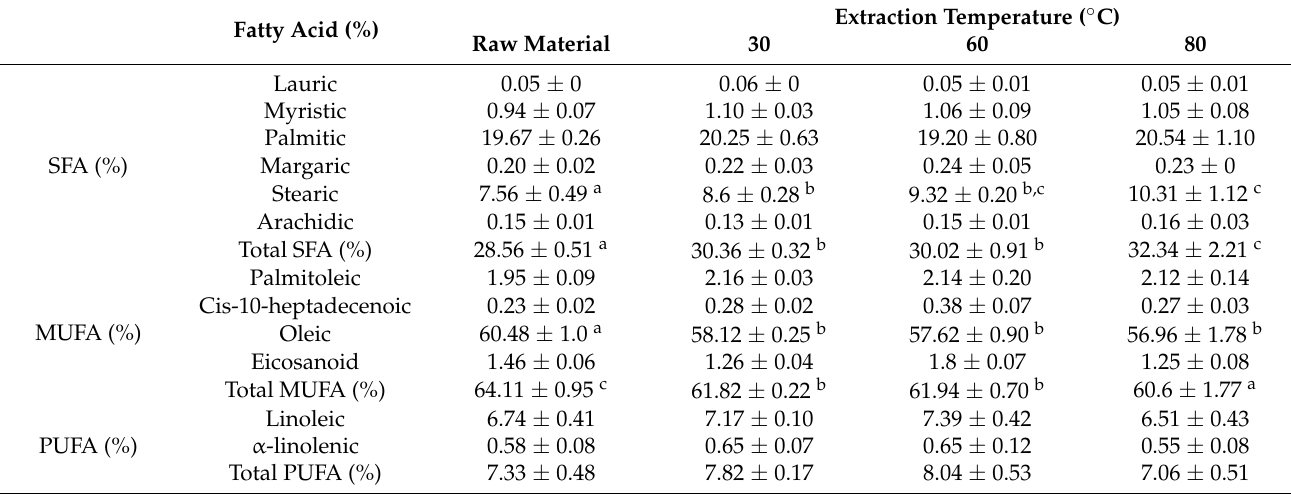
Table 2. Fatty acid composition of the selected